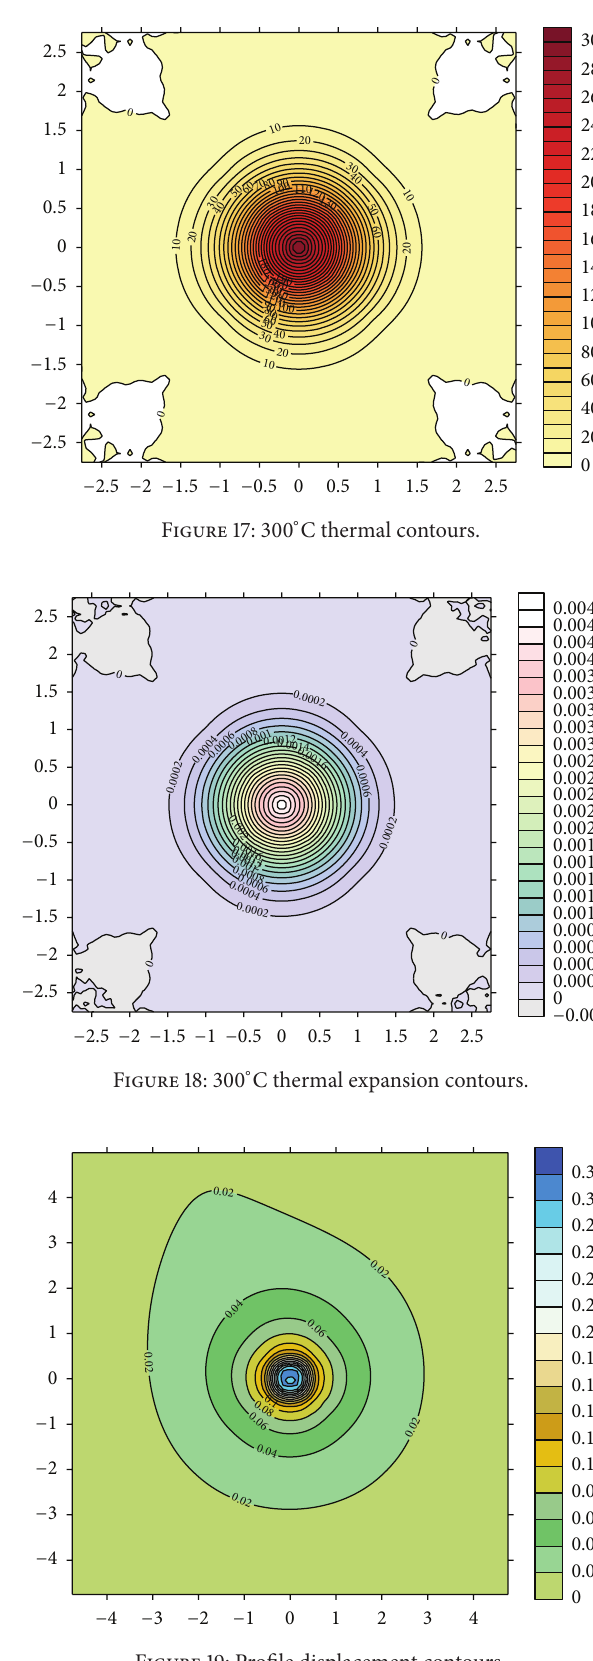
Figure 19: Profile displacement